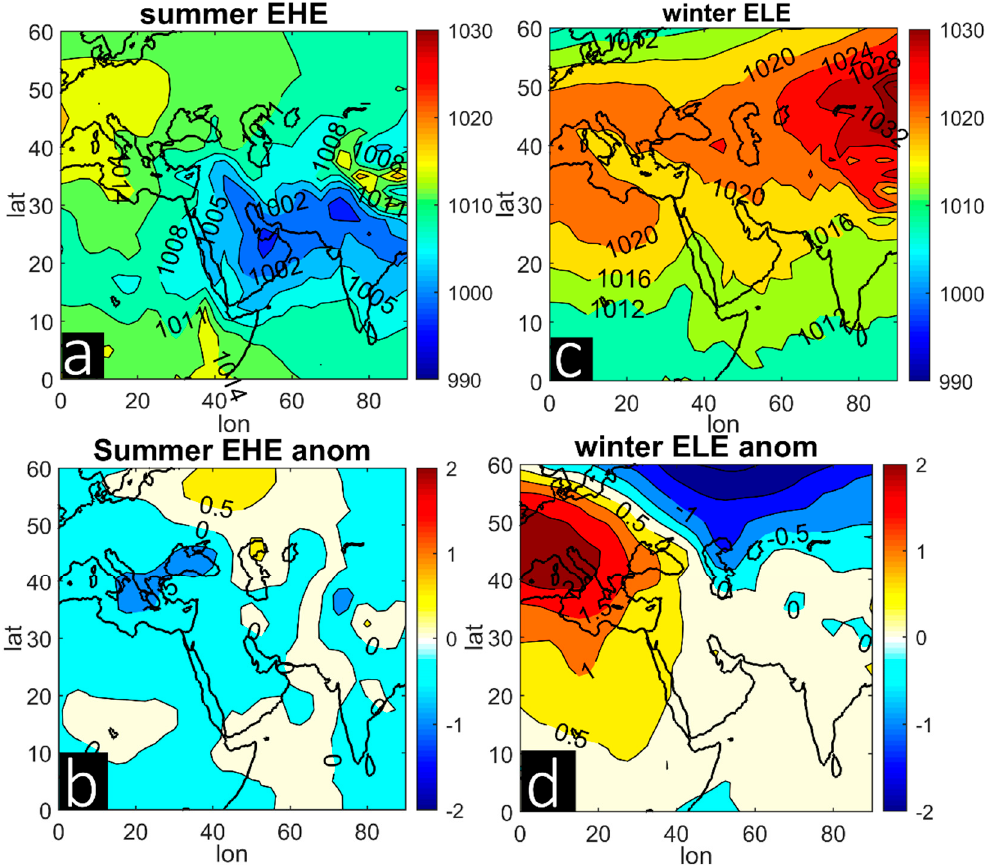
Figure 4. Composite SLP ( a ) and associated anomaly values ( b ) in hPa for EHEs. Same for ( c ) and ( d ), but for ELEs.